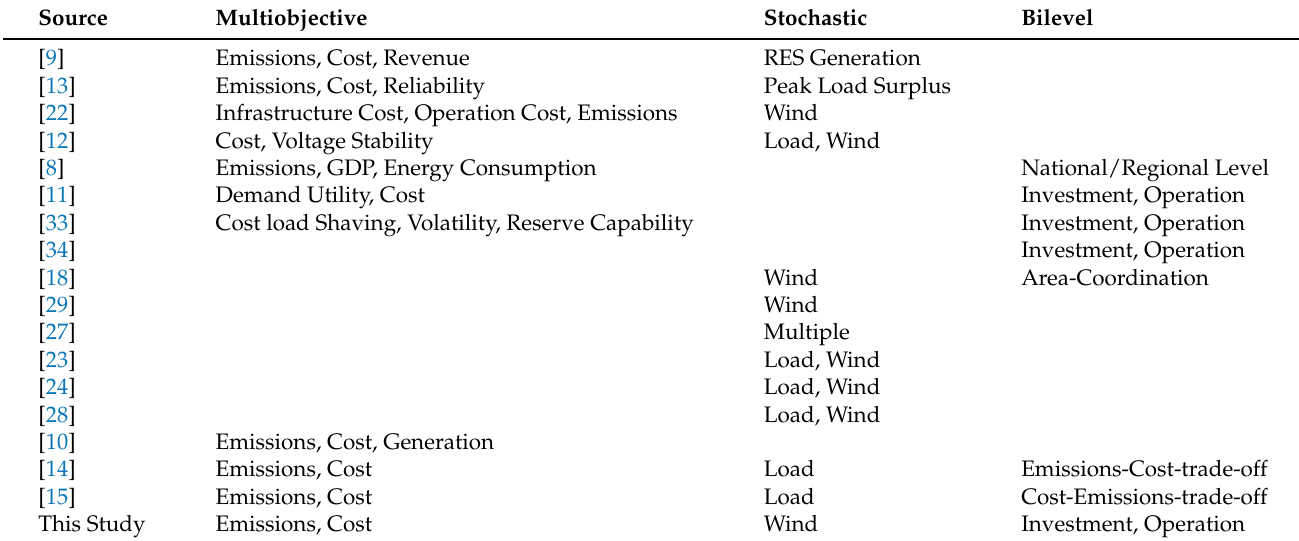
Table 1. Classification of the closest related